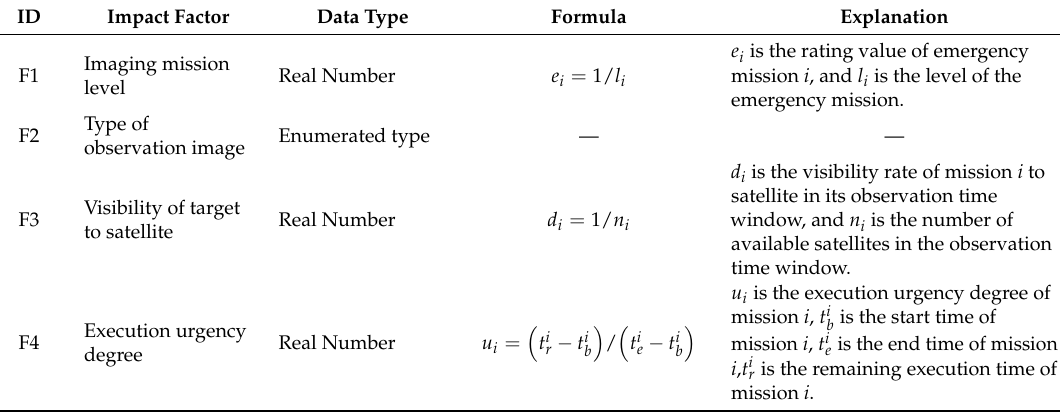
Table 1. Impact factors of mission